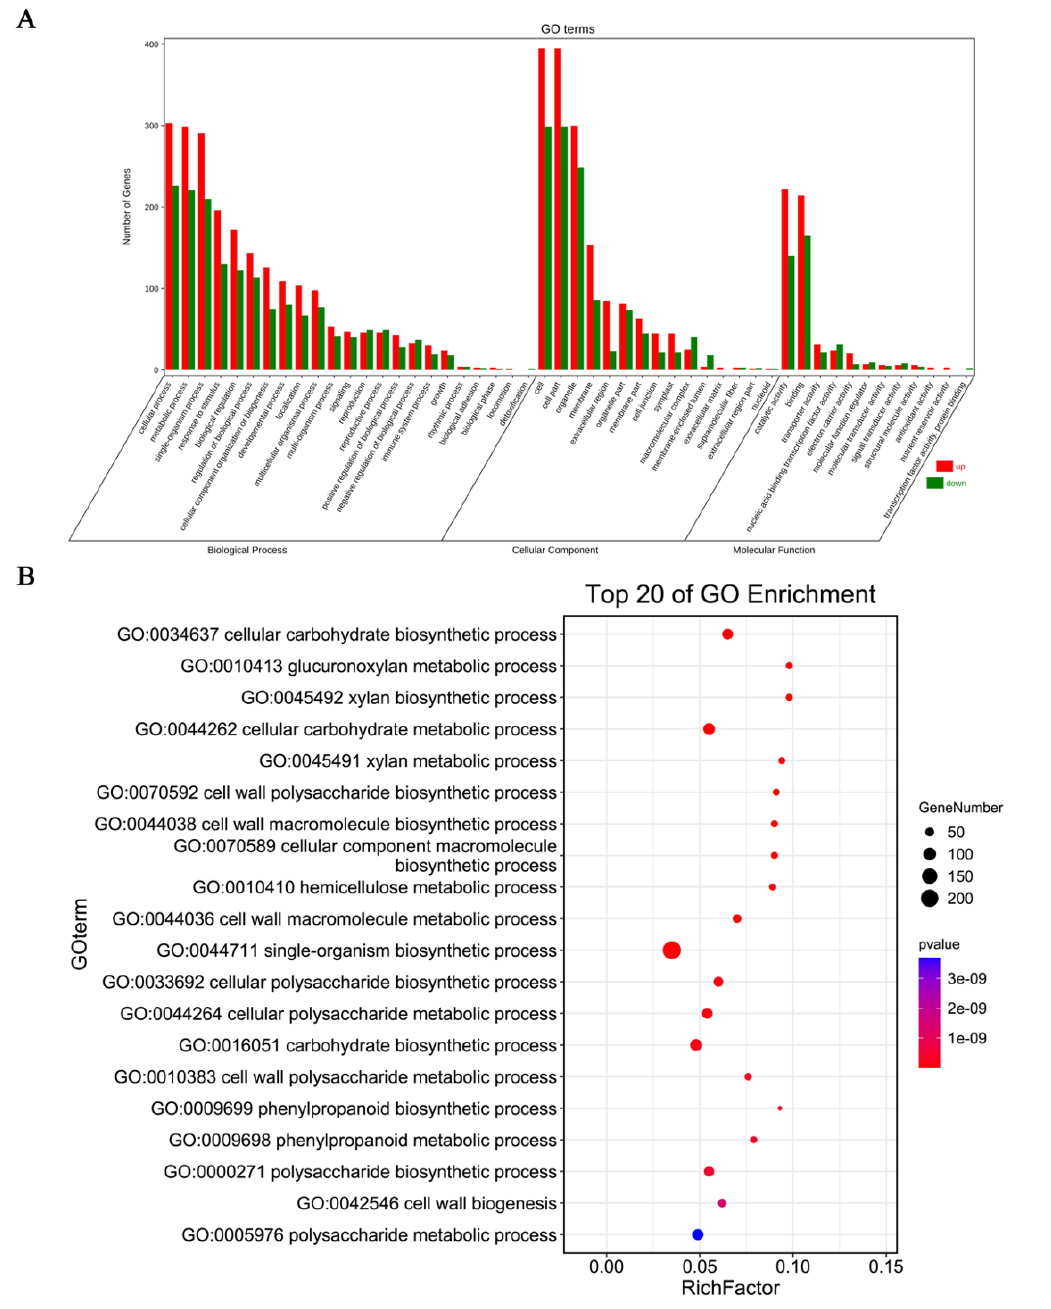
Figure 2. Gene Ontology classification enrichment analysis results of DEGs. GO classification of upregulated and downregulated DEGs ( A ), the Top 20 GO enrichment process ( B ). Rich Factor: DEGs numbers/total gene numbers enriched in the process. Table 2. Anthocyanin-Containing Compound Biosynthetic Process (qvalue = 2.71 × 10 − 6 ).